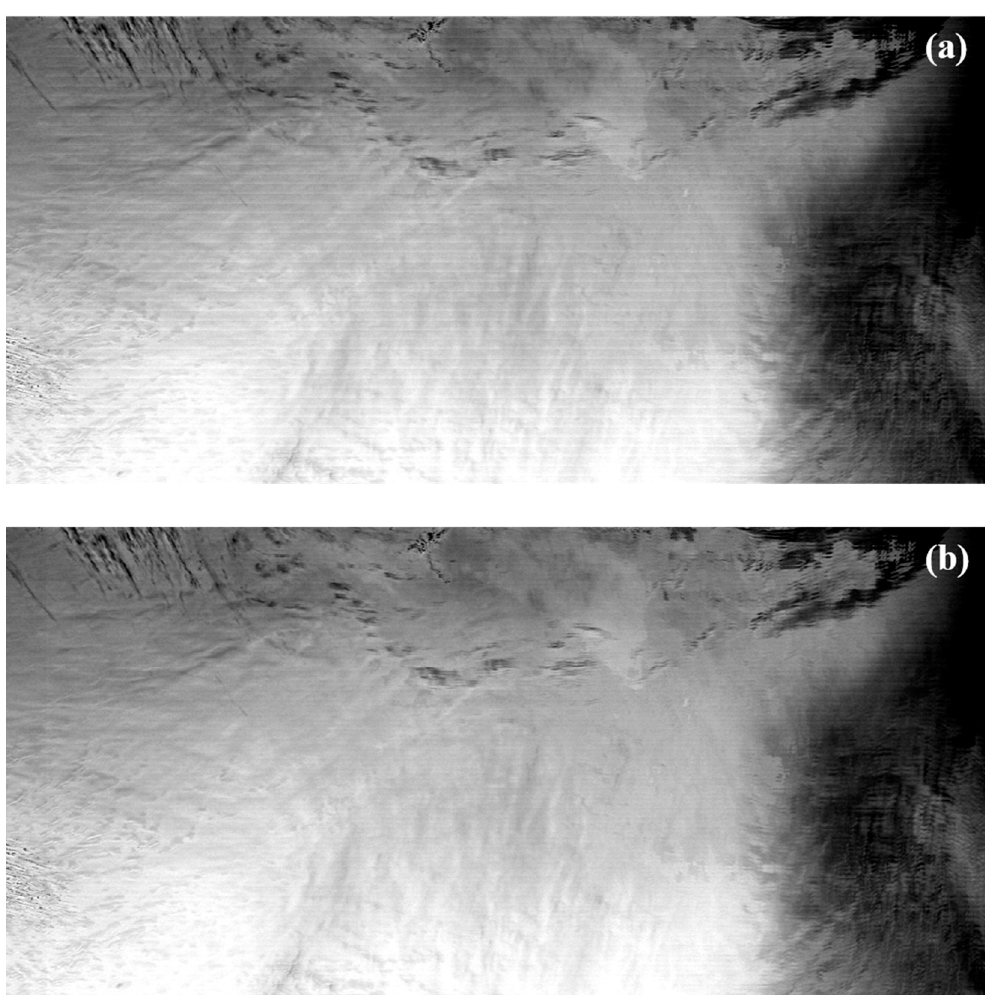
Figure 11. ( a ) Original NOAA-20 VIIRS DNB daytime image recorded over Antarctica at 8:34 UTC, 14 December 2020. The 768 × 768 (track × scan) pixels are on the right side of the granule (aggregation zone 21). ( b ) Reprocessed image using the updated NOAA-20 VIIRS DNB LGS Gains LUT.